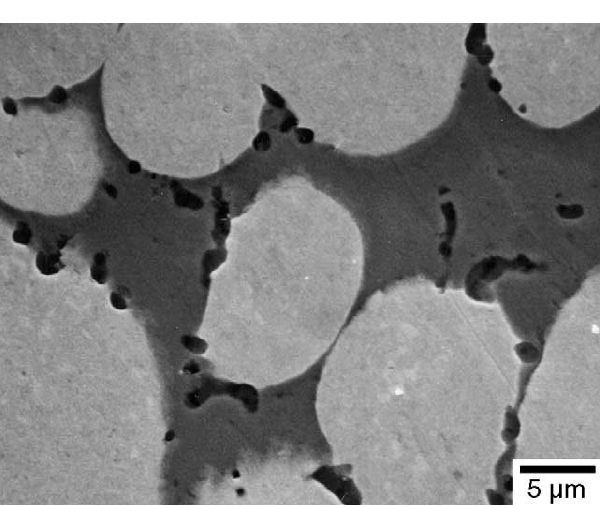
Figure 11. SEM micrograph of a mechanically alloyed oxide dispersion of 1 wt% Y 2 O 3 in W-5.6Ni-1.4Fe sintered at 1485 °C for 60 min [80]. Reproduced with permission from Ryu et al.,